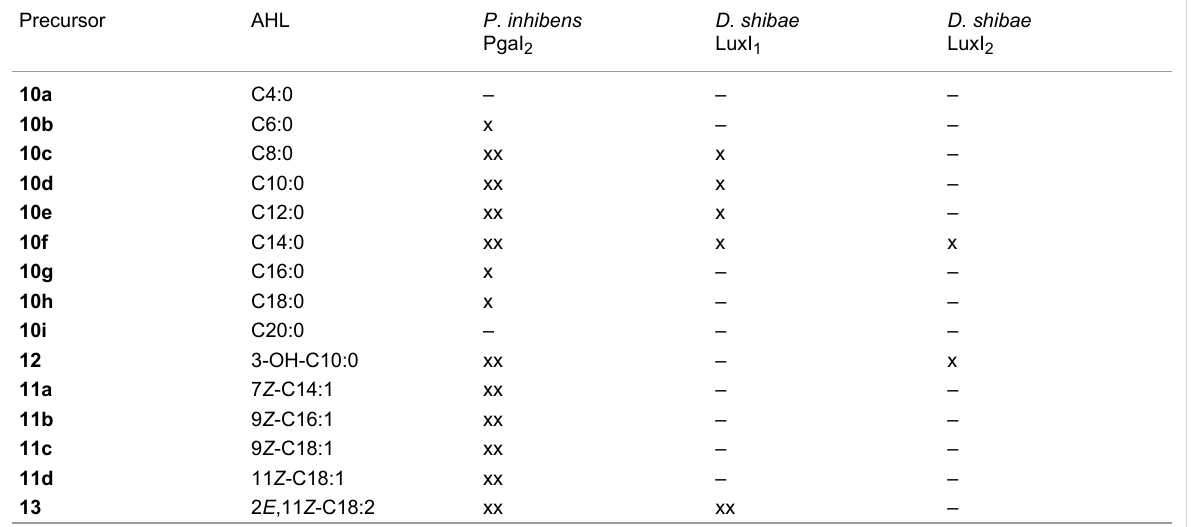
Table 3: Results of incubation experiments of single precursors 10 – 13 with E. coli constructs with recombinant AHL synthases PgaI 2 , LuxI 1 and LuxI 2 from different Roseobacter group bacteria. a Precursor